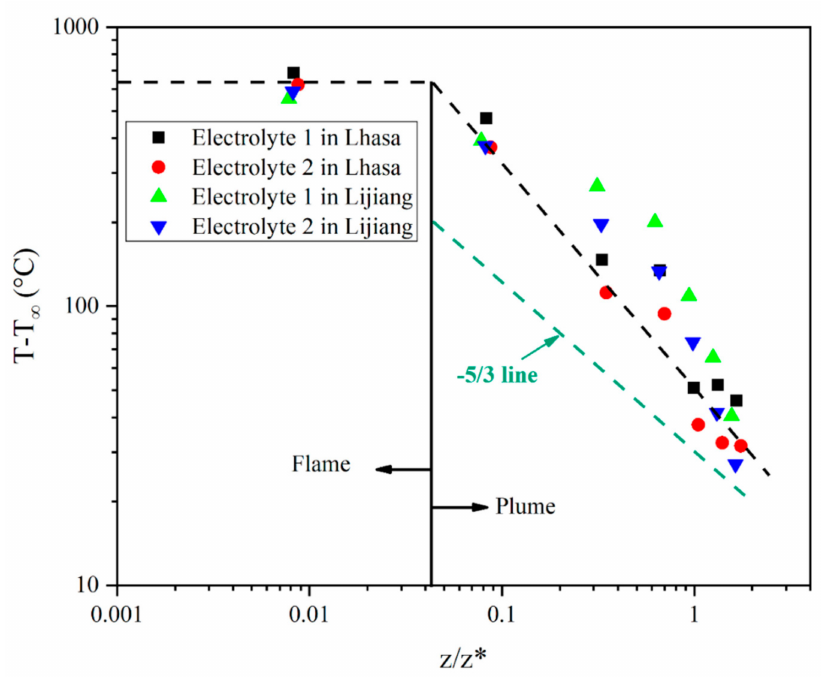
Figure 8. The average fire centerline temperatures rising distribution in different flame plume